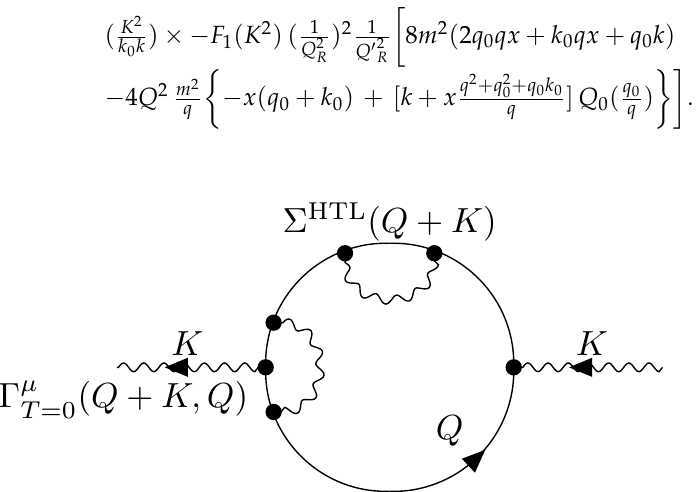
Figure 6. Another three-loop contribution to the polarization tensor Π ( 3 ) ( k 0 , k , T )